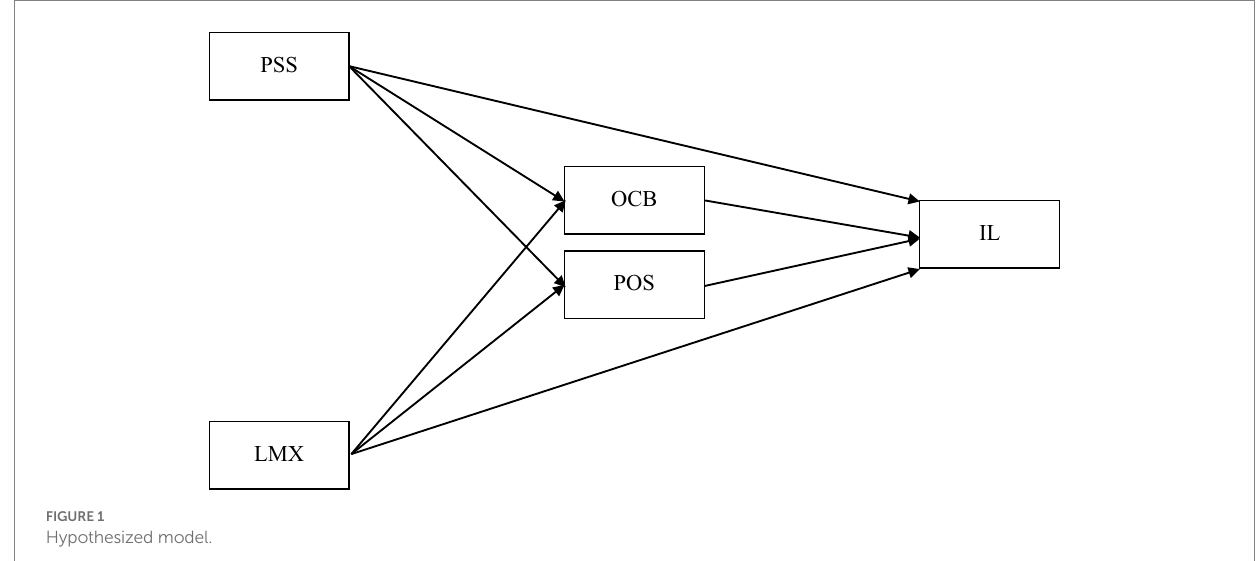
FIGURE 1 Hypothesized